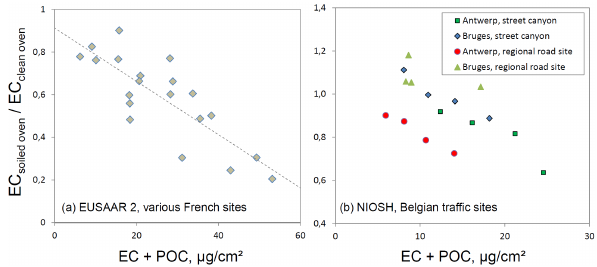
Fig. 6. Time evolution of the laser transmission signal intensity during instrumental blank analysis with a clean and a soiled oven, using a Sunset Lab. analyzer. For comparison purposes, the laser signals have been normalized to their initial value.